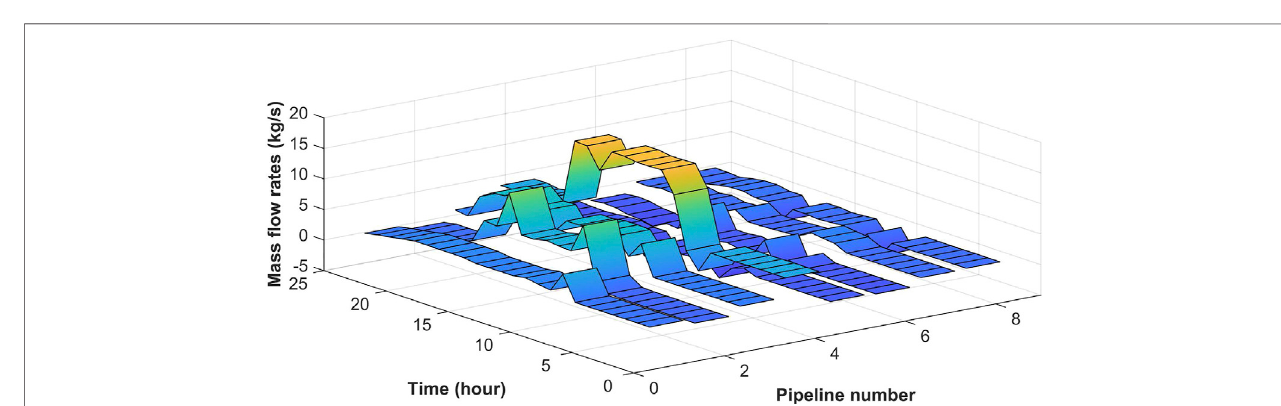
FIGURE 10 | Mass fl ow rate for each pipe in the heat network.